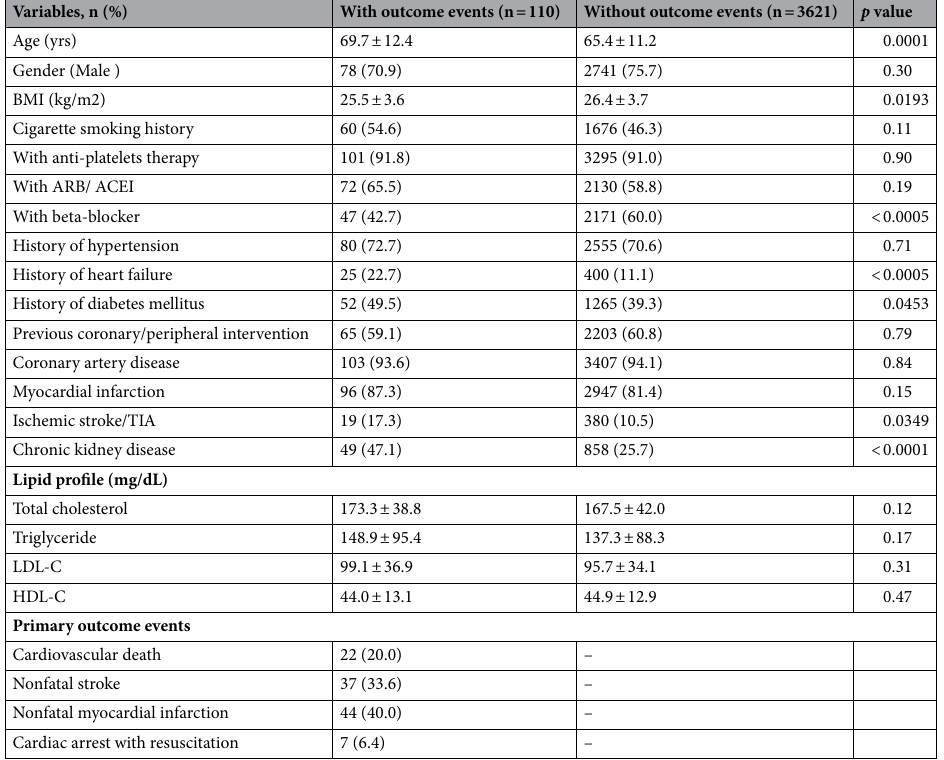
Table 3. Baseline characteristics in patients with and without primary outcome events. *Abbreviations are the same as the Table